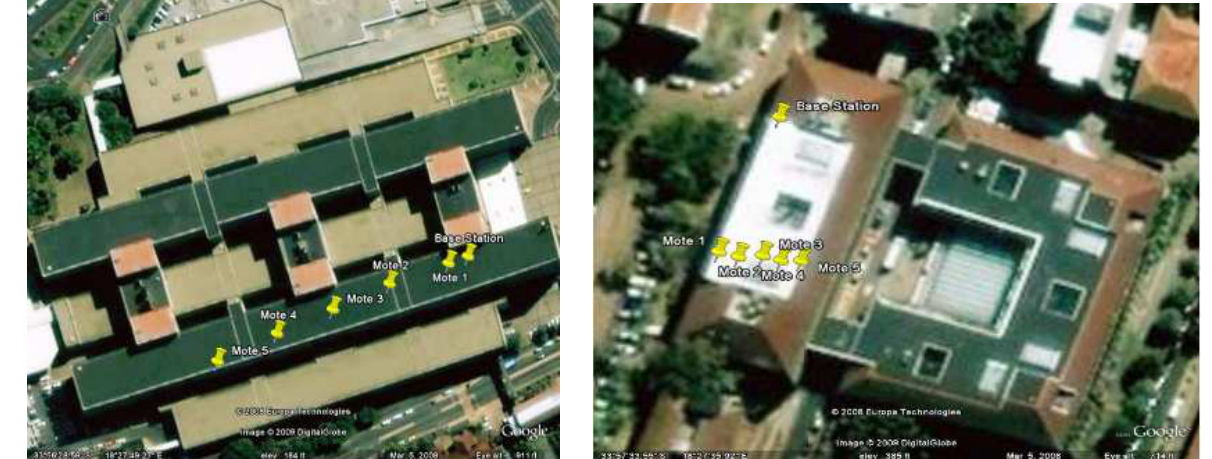
Figure 4. The two outdoor testbeds.